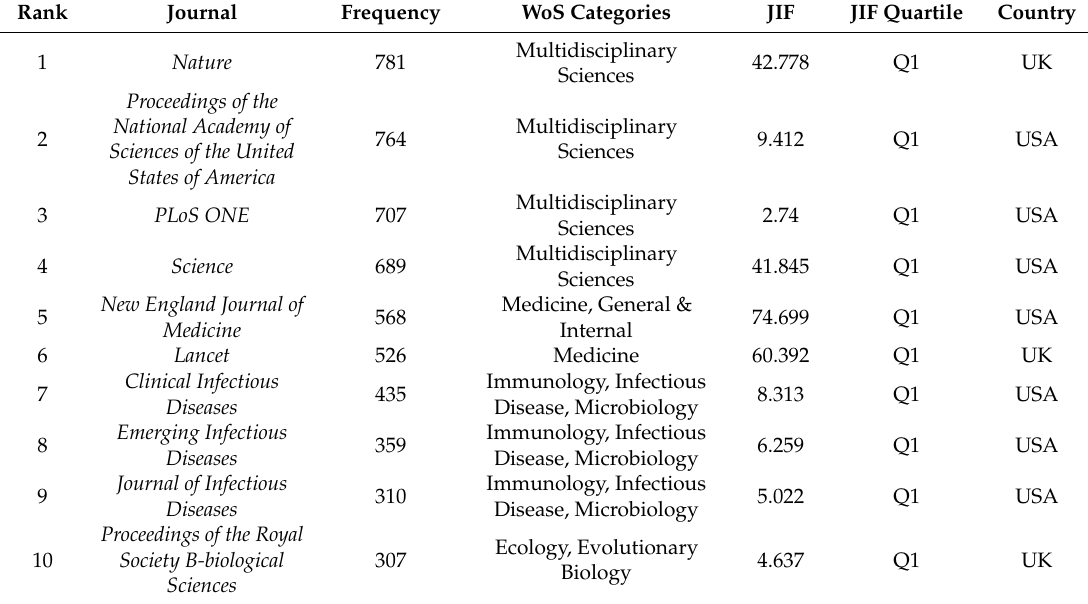
Table 1. The top 10 cited journals in the field of prediction of infectious diseases (up to 1 May 2020).